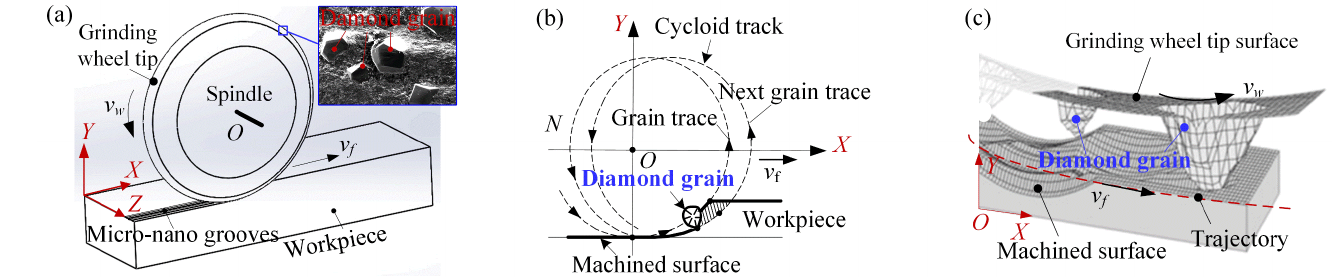
Figure 1. Structural characteristics of bamboo leaf for droplet steering. ( a ) The morphologies of nat- ural bamboo leaf; ( b ) the SEM photo of the fresh bamboo leaf using an environmental scanning electron microscope; ( c ) the Abbott – Firestone curve of the morphology; ( d ) and ( e ) are photos of bamboo leaf in the hydration and hydropenia states, respectively; ( f ) droplets pinned on the verti-